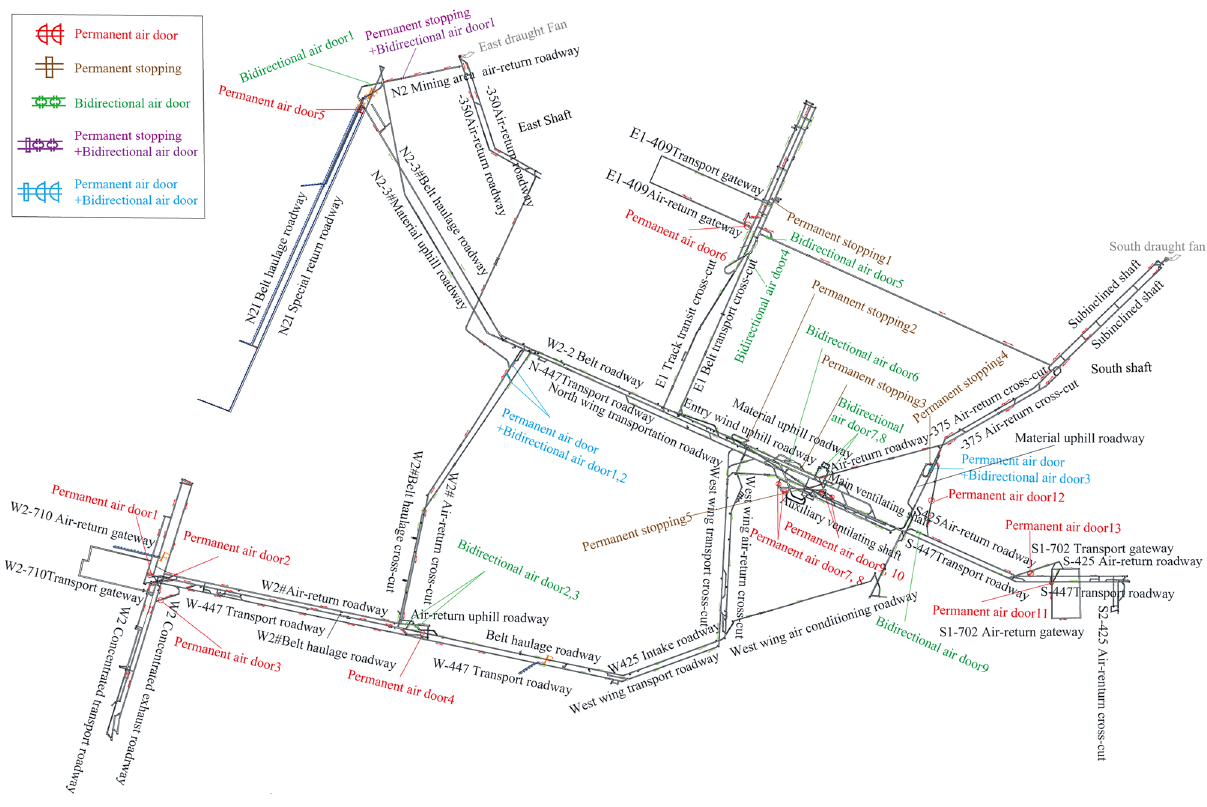
Figure 5. XQ mine System diagram.